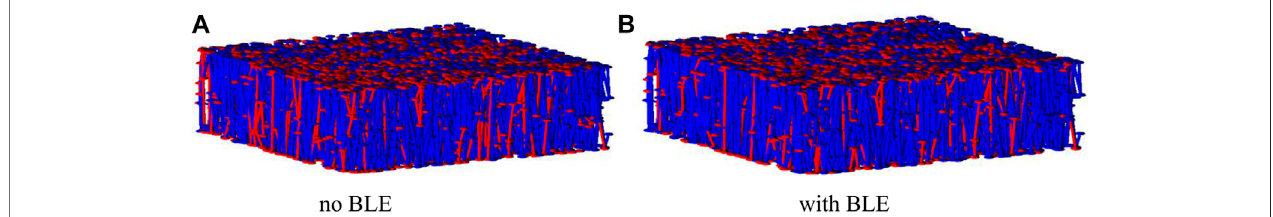
FIGURE 19 | Comparison of oil – water distribution under BLE. (A) Without BLE and (B) with BLE.